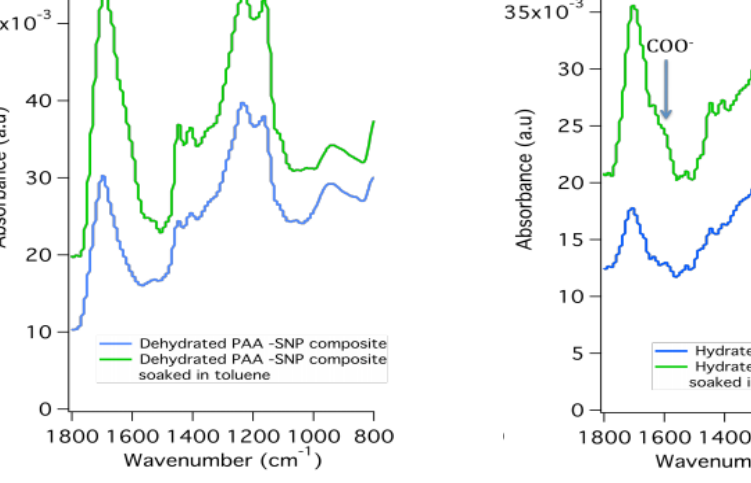
Figure 10. FT-IR spectra of the composite mats. In the spectra on the right, the presence of the shoulder indicated the carboxylic acids are